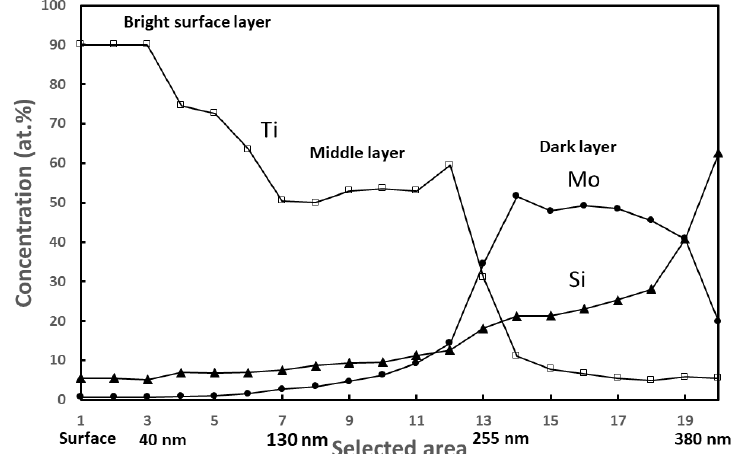
Figure 9. EDS Line scan results providing the concentration of Ti, Mo and Si (at.%) in Mo–Ti bilayer films heated at 800 °C and exposed to (Ar-31%N 2 -6%H 2 ) plasma for 1 h 30 min.